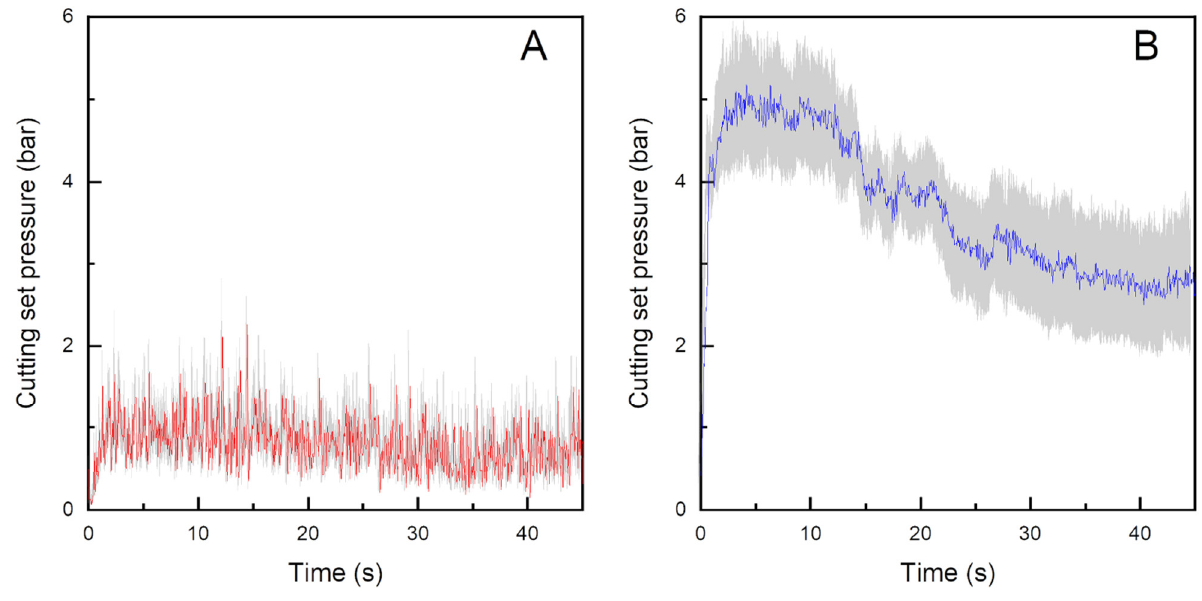
Figure 6. Mean (red and blue lines) and standard errors (grey lines) of cutting set pressures during the first (red line) ( A ) and second (blue line) ( B ) grinding steps in beef patty manufacturing, n = 12.